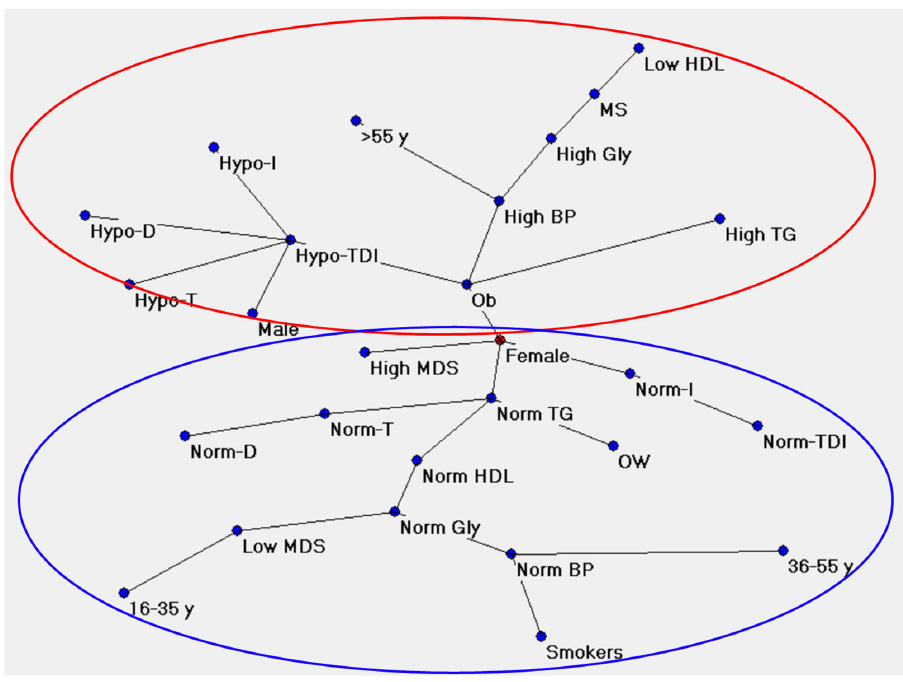
Figure 6. Map I shows the connections among variables in the unhealthy (red circle) or healthy (blue circle) form.